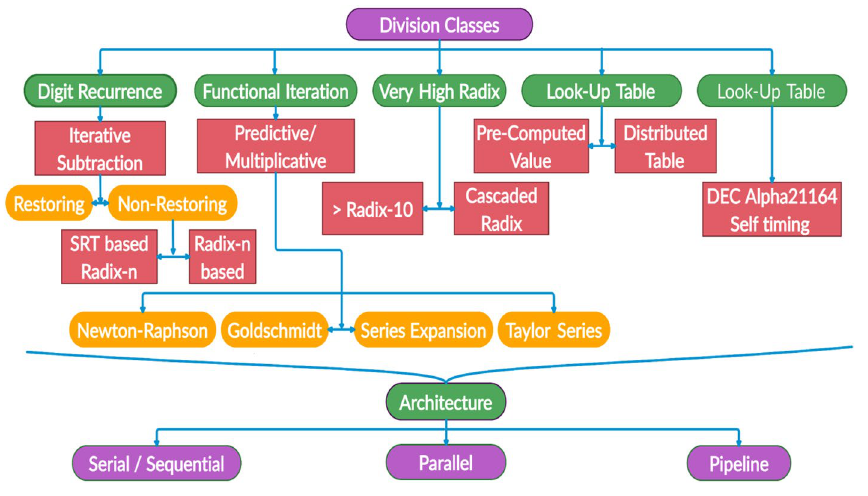
Figure 1. Division algorithm